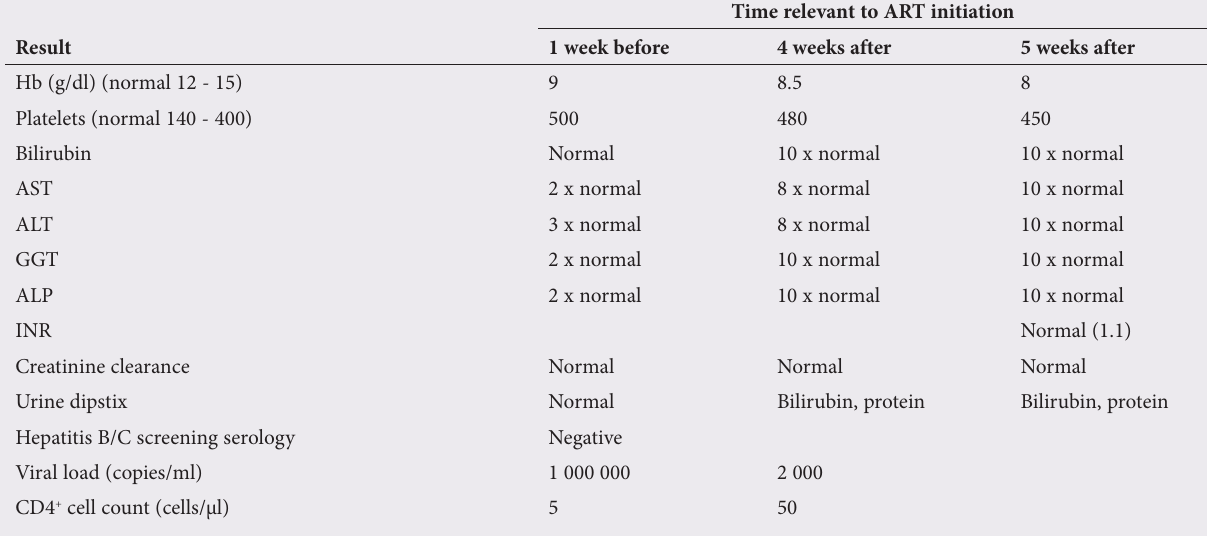
Table 1. Patient blood test results before and after ART initiation